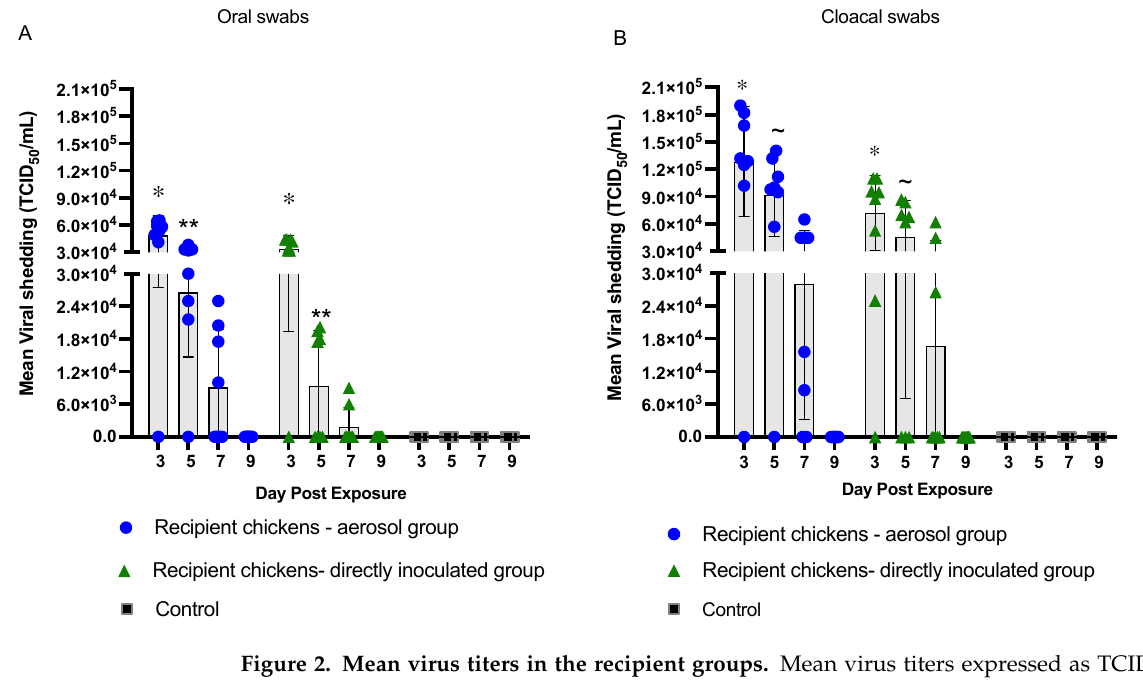
Figure 2. Mean virus titers in the recipient groups. Mean virus titers expressed as TCID50/mL in oral ( A ) and cloacal ( B ) swabs from the recipient chickens (n = 8/model) are shown on days 3, 5, 7, and 9 PE. Each data point on the graph represents an individual chicken. Twenty-four hours post-inoculation of the inoculated seeder groups, recipient (healthy and uninfected) chickens were added to the respective seeder groups. Data were analyzed using nonparametric Mann–Whitney unpaired Student’s t-test. The results were considered significant between the groups when */~ p < 0.05, or ** p value < 0.01 . Table 2. Rate of infection in recipient chickens of aerosol and direct inoculation groups. No. of Swabs Positive/No. of Swabs Tested